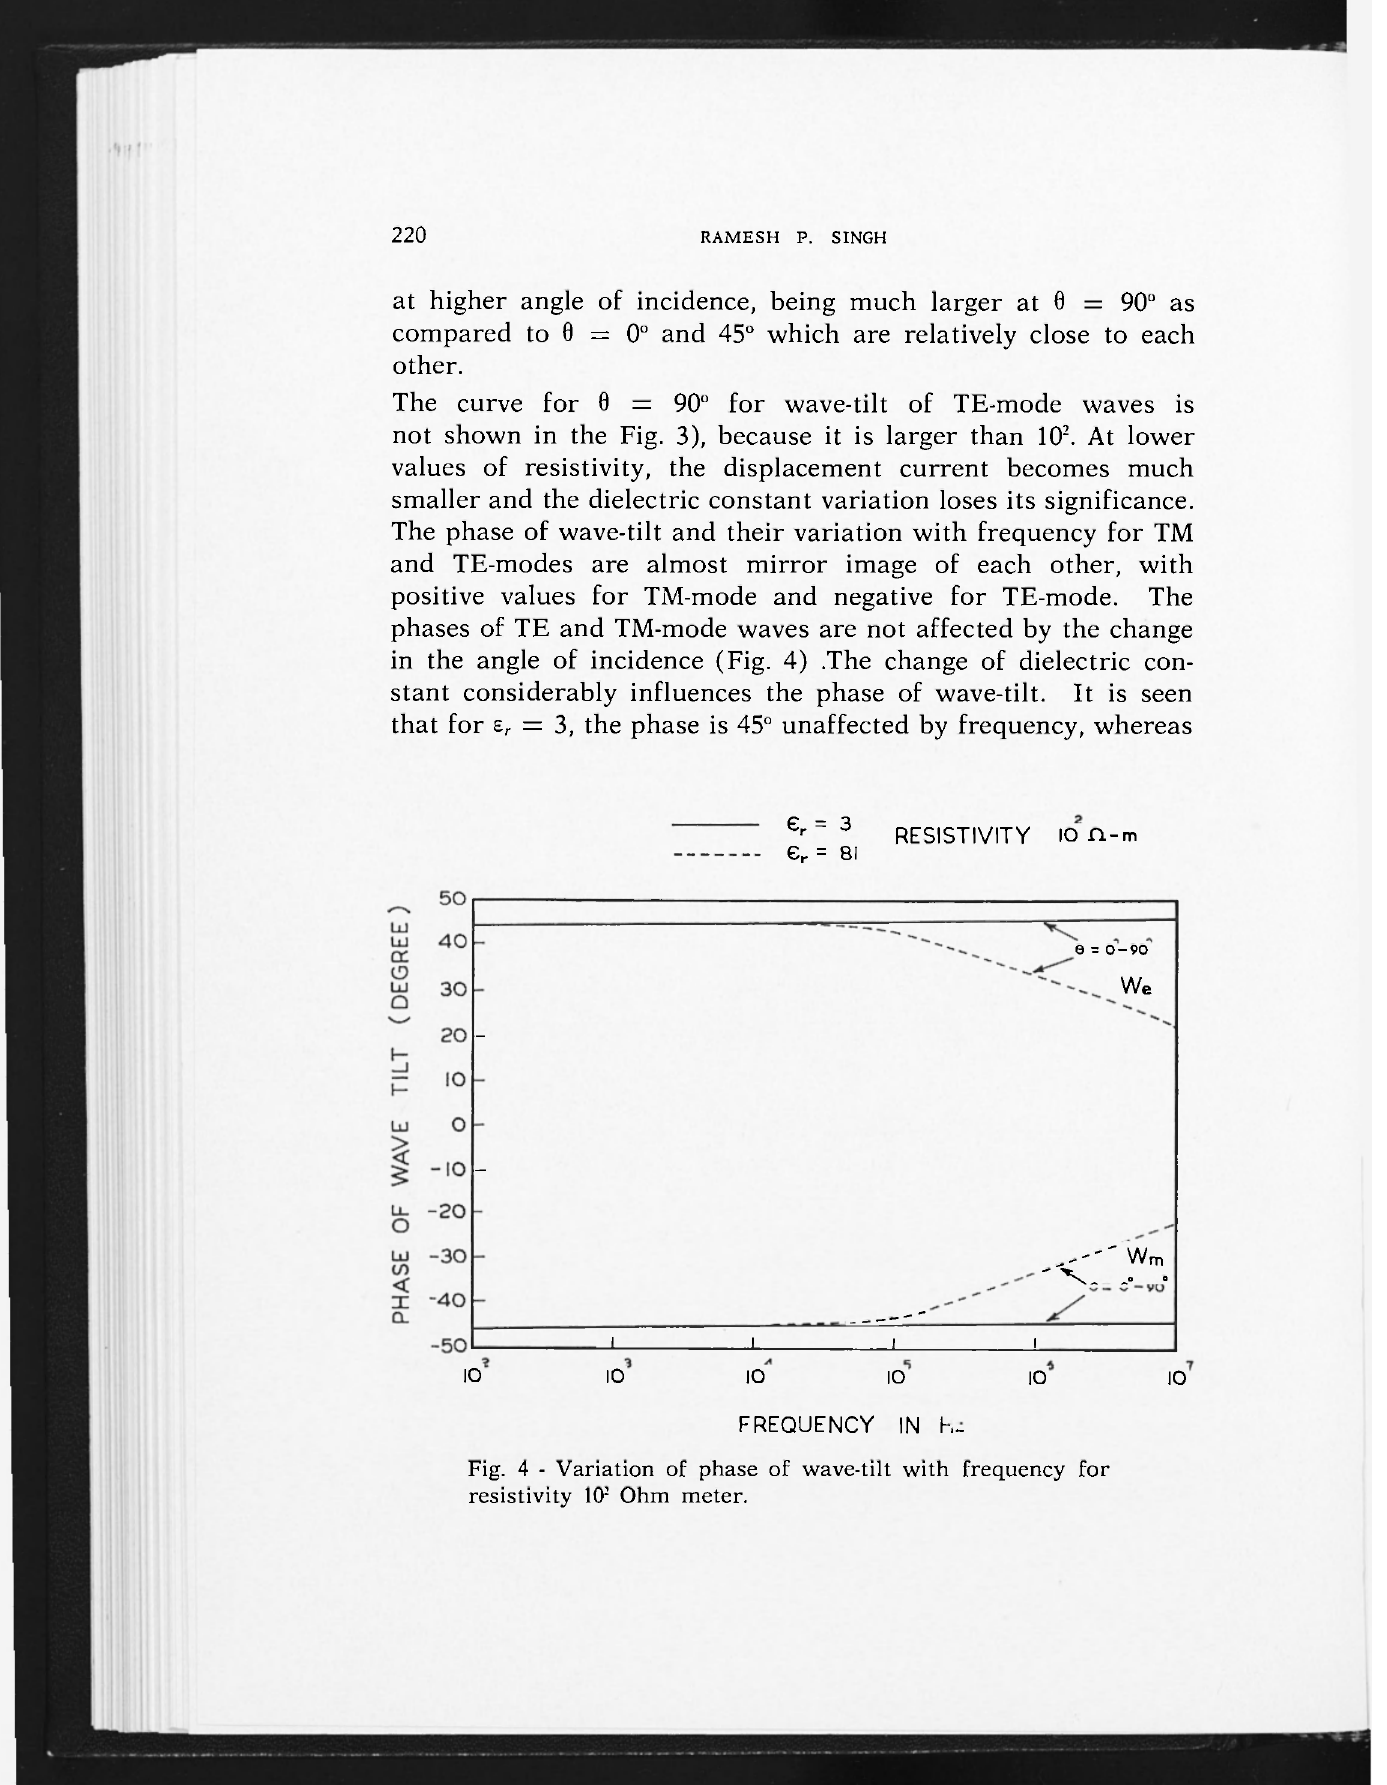
Fig. 4 - Variation of phase of wave-tilt with frequency for resistivity 10 2 Ohm